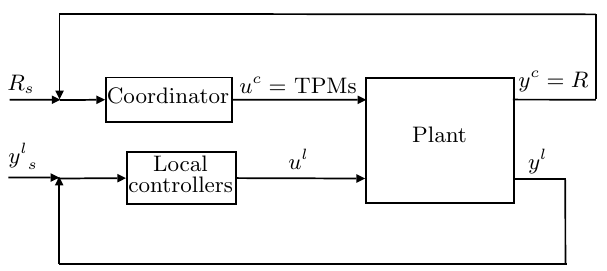
Figure 1: The coordinator uses the throughput manip- ulators ( u c = TPMs) to control the remain- ing capacity ( y c = R ) in the